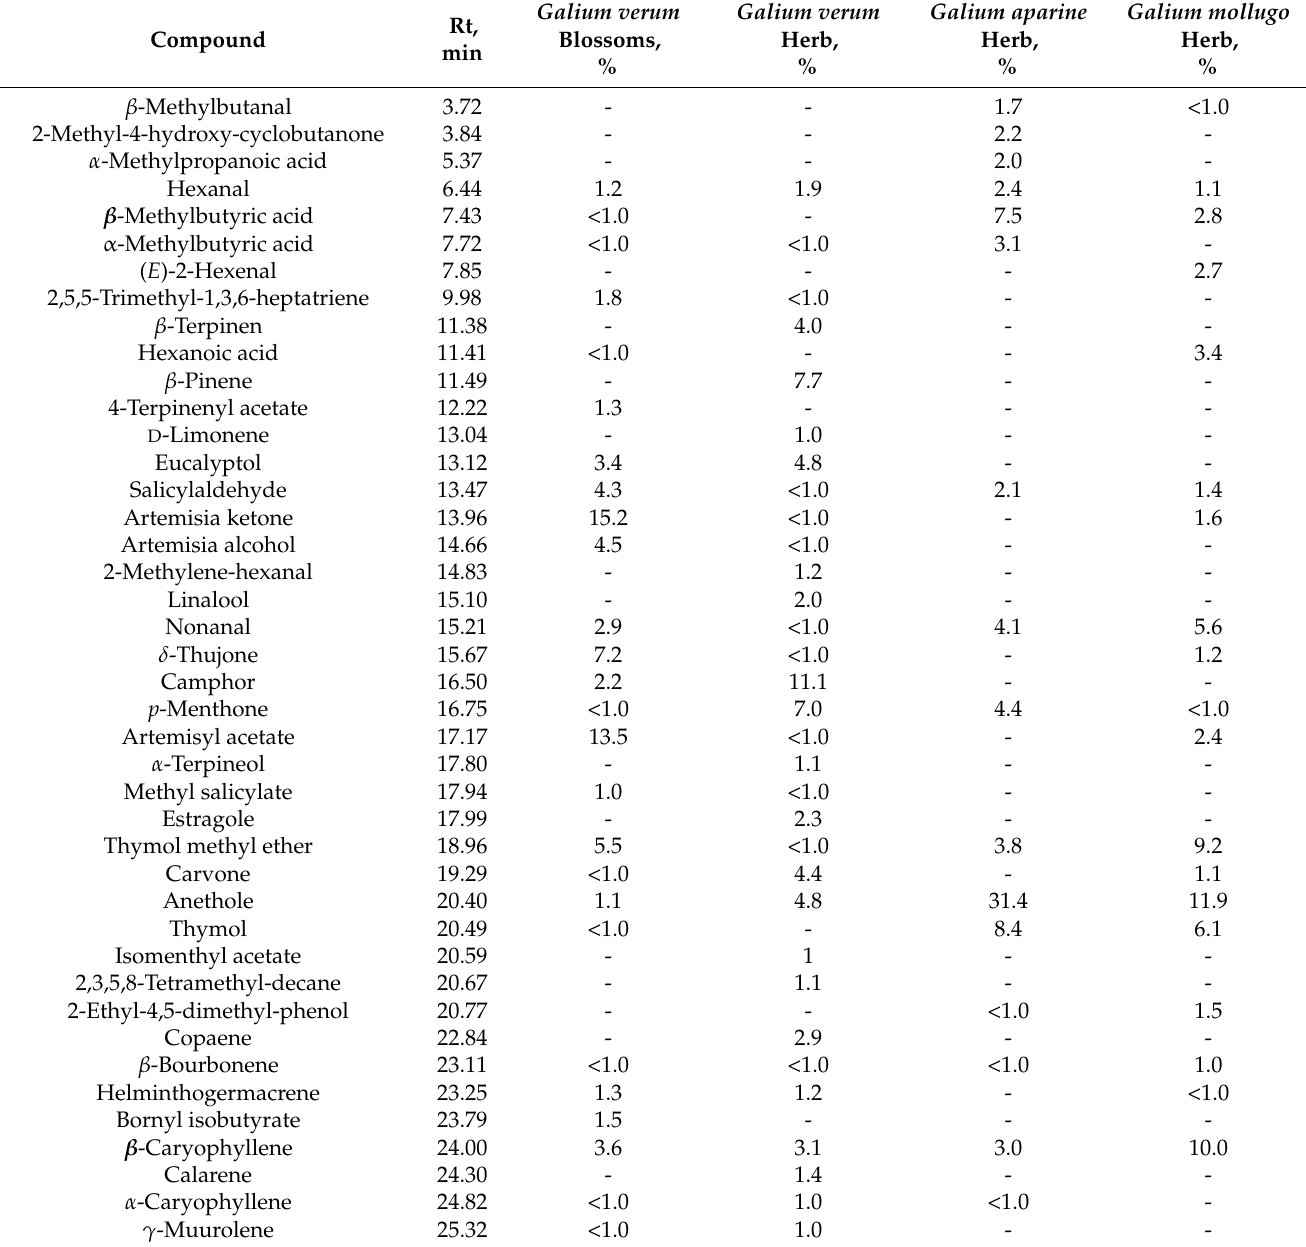
Table 4. Identified volatile compounds in the samples of the Galium